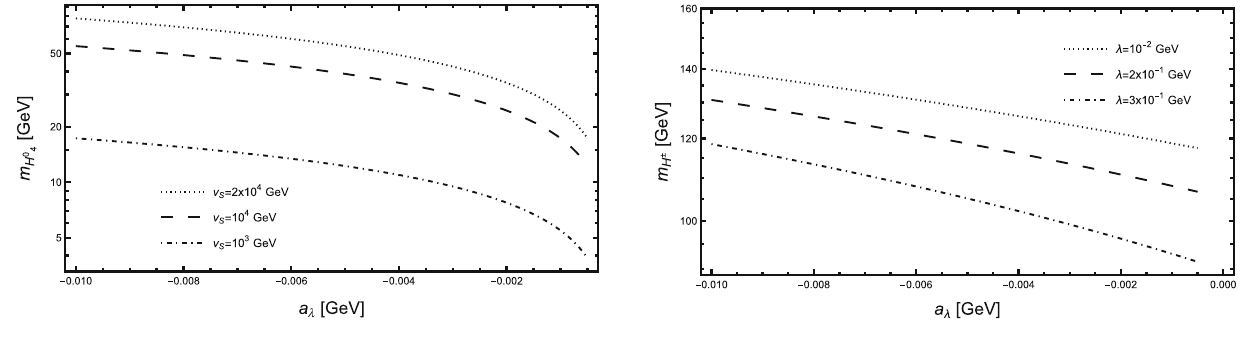
Fig. 5 Mass values of the charged Higgs as a function of the scalar Fig. 4 Mass values of the CP-odd sector pseudo-scalar Higgs boson potential parameter a λ for different values of λ . Here we have chosen as a function of the scalar potential parameter a λ for different values of v β = 30 and v = 246 GeV tan β = 30, v 2 = 246 GeV and v S = 2 × 10 4 S . Here we have chosen tan 2